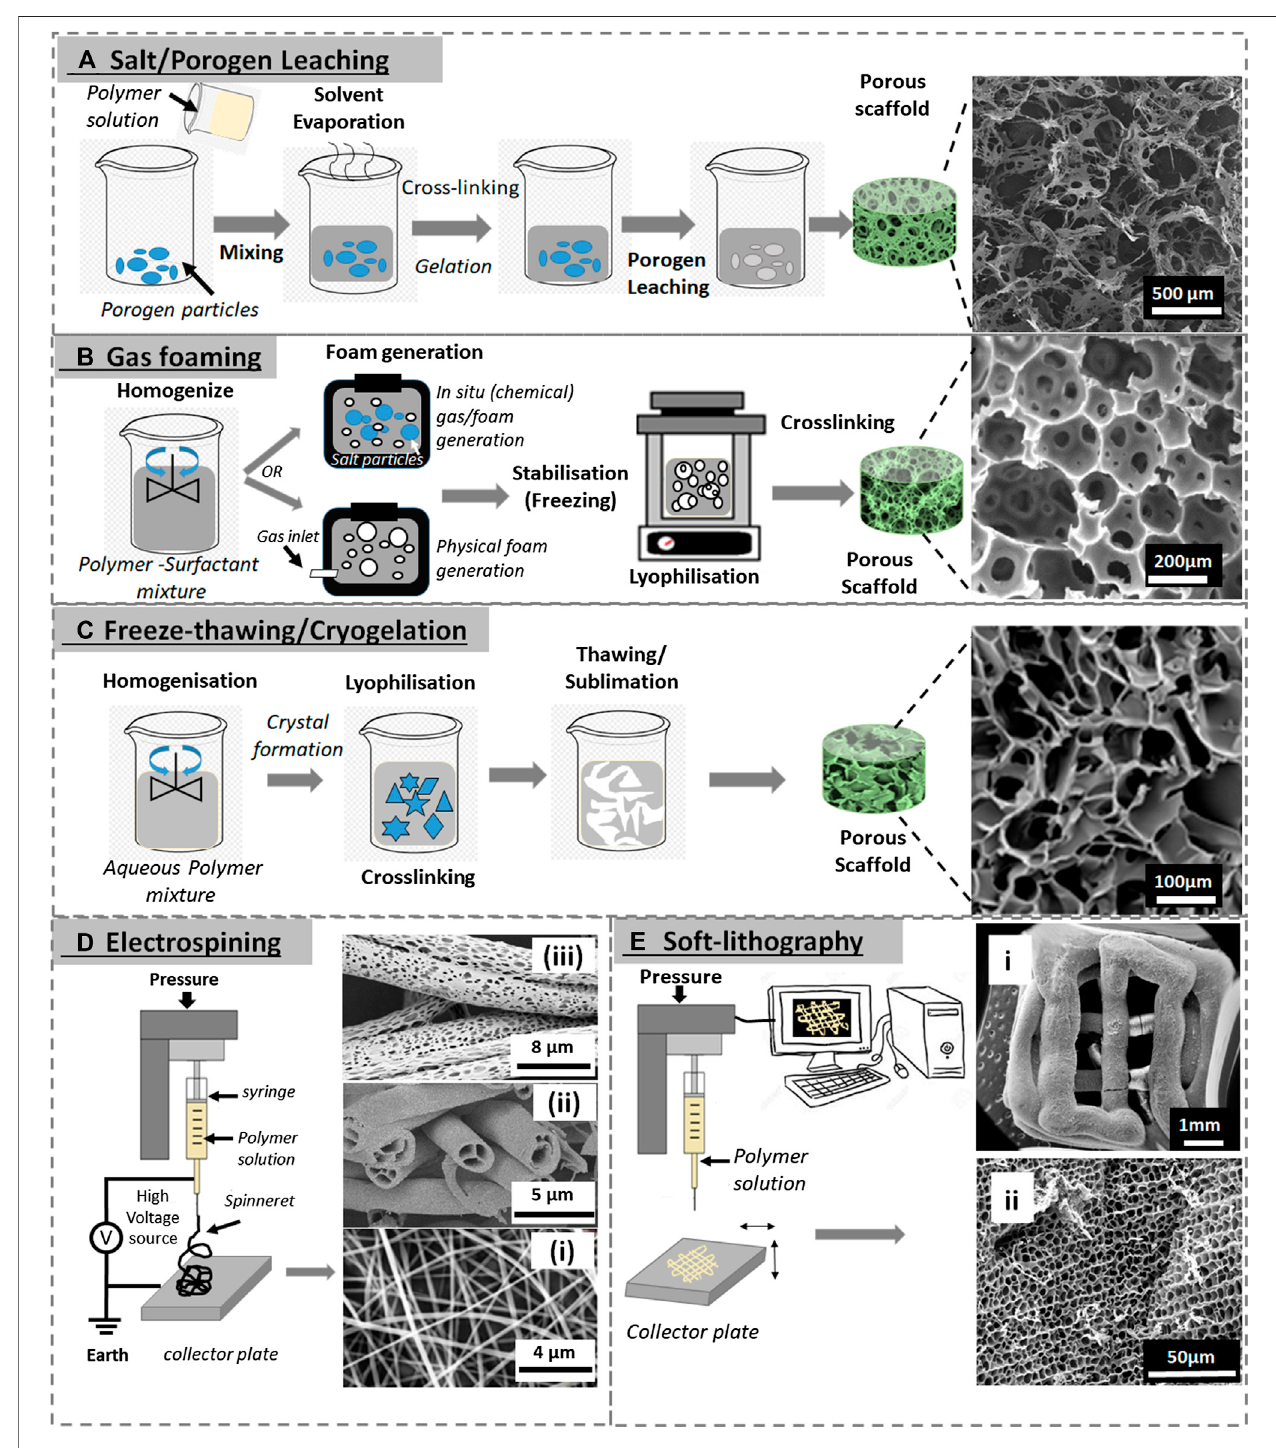
FIGURE 1 | Various porous scaffold fabrication techniques. (A) Porogen leaching (SEM image reproduced with permission from Yao et al. (2012), copyright 2012, American Chemical Society). (B) Gas foaming (SEM image reproduced with permission from Colosi et al. (2013), copyright 2013, American Chemical Society). (C) Freeze-thawing (SEM image reproduced with permission from Elowsson et al. (2013), copyright 2013, The Royal Society of Chemistry). (D) Solution electrospinning: i) SEM images of electrospun ELR fi bers (mat), reproduced with permission from Putzu et al. (2016), copyright IOP Publishing; ii) hollow electrospun fi bers adapted with permission from Zhao et al. (2007) copyright 2007, American Chemical Society; and iii) porous electrospun fi bers adapted with permission from Katsogiannis et al. (2016),copyrightJohnWileyandSons. (E) Softlithography(3Dprinting):i)andii)whole3D-printedscaffoldandii)anSEMimageofitsinternalporousstructure,bothare reproduced with permission from Salinas-Fernández et al. (2020), copyright 2020,